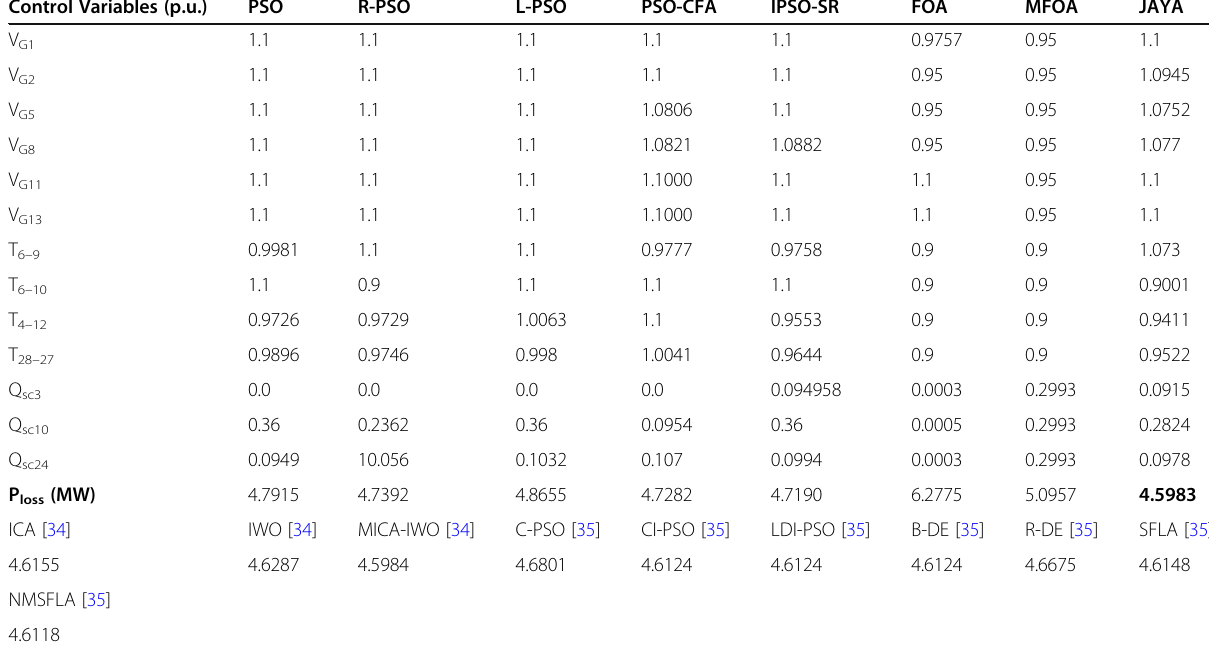
Table 4 Simulation results on the IEEE 30 bus system using different algorithms without DG injection Control Variables